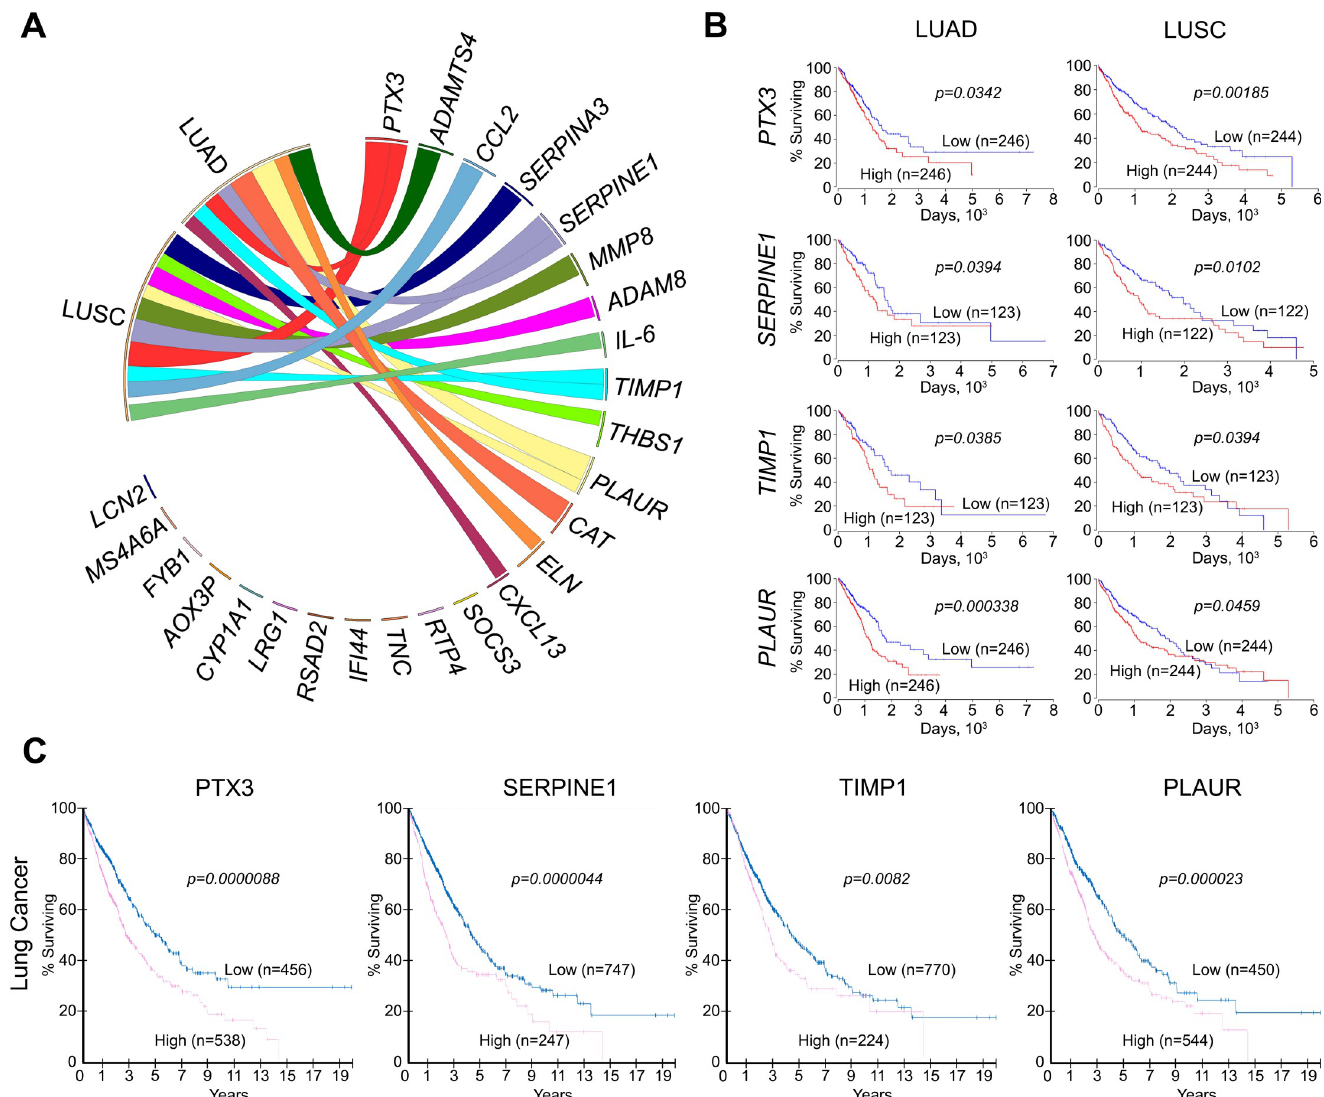
Fig 4. Association of identified DEGs with survival of patients with lung adenocarcinoma (LUAD) and lung squamous cell carcinoma (LUSC). ( A ) Survival analysis of DEGs was performed using The Cancer Genome Atlas (TCGA) data for patients with LUAD and LUSC. Visualisation was performed via Circos. The width of ribbons corresponds with the log-rank p -value, with wider ribbons indicating a more significant correlation. The ribbons of ELN and CAT indicate that low expression of these genes is associated with poor survival of patients, as opposed to the other genes, for which high expression is associated with poor survival. The absence of ribbons indicates no significant correlation between gene expression and patient survival. ( B ) Survival of patients with LUAD and LUSC depending on the level of particular gene expression in the lung tissue (mRNA level). Kaplan-Meier survival curves were constructed based on TCGA data using OncoLnc. ( C ) Survival of patients with lung cancers depending on the level of particular gene expression in the lung tissue (protein level). Kaplan-Meier survival curves were constructed based on The Human Protein Atlas